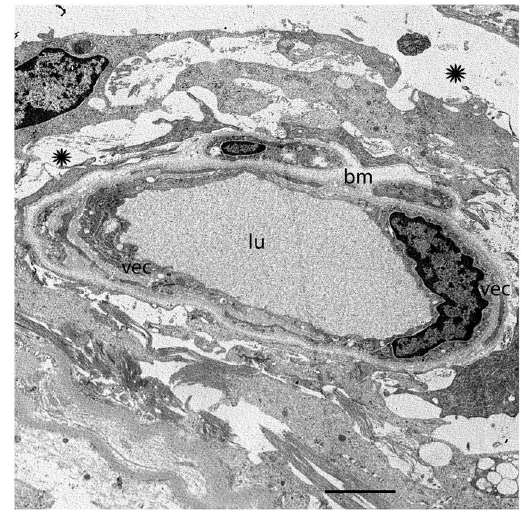
Figure 5. A BLB capillary with moderate degenerative changes in Meniere’s disease (40-year-old). Vacuolization is seen in vascular endothelial cells (vec), and there is apparent degeneration with loss of organelles and thinning. The perivascular basement membrane (bm) shows thickening. Lumen (lu). The stroma shows signs of edema (asterisk). Bar = 2 μ m.